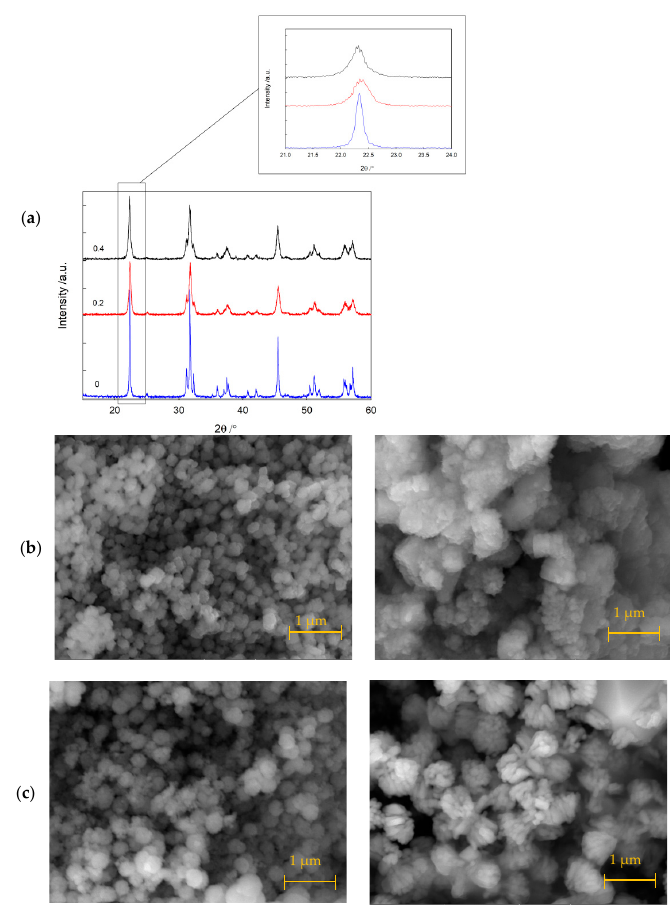
Figure 7. ( a ) XRPD patterns of NaMnF 3 prepared with different amounts of sodium citrate (0 g; 0.2 g; 0.4 g), showing the broadening of the diffraction peaks when sodium citrate was present in the reaction mixture. ( b ) SEM images of the NaMnF 3 compound prepared with (left) and without (right) sodium citrate; ( c ) SEM images of the NaCoF 3 compound prepared with (left) and without (right) sodium citrate.